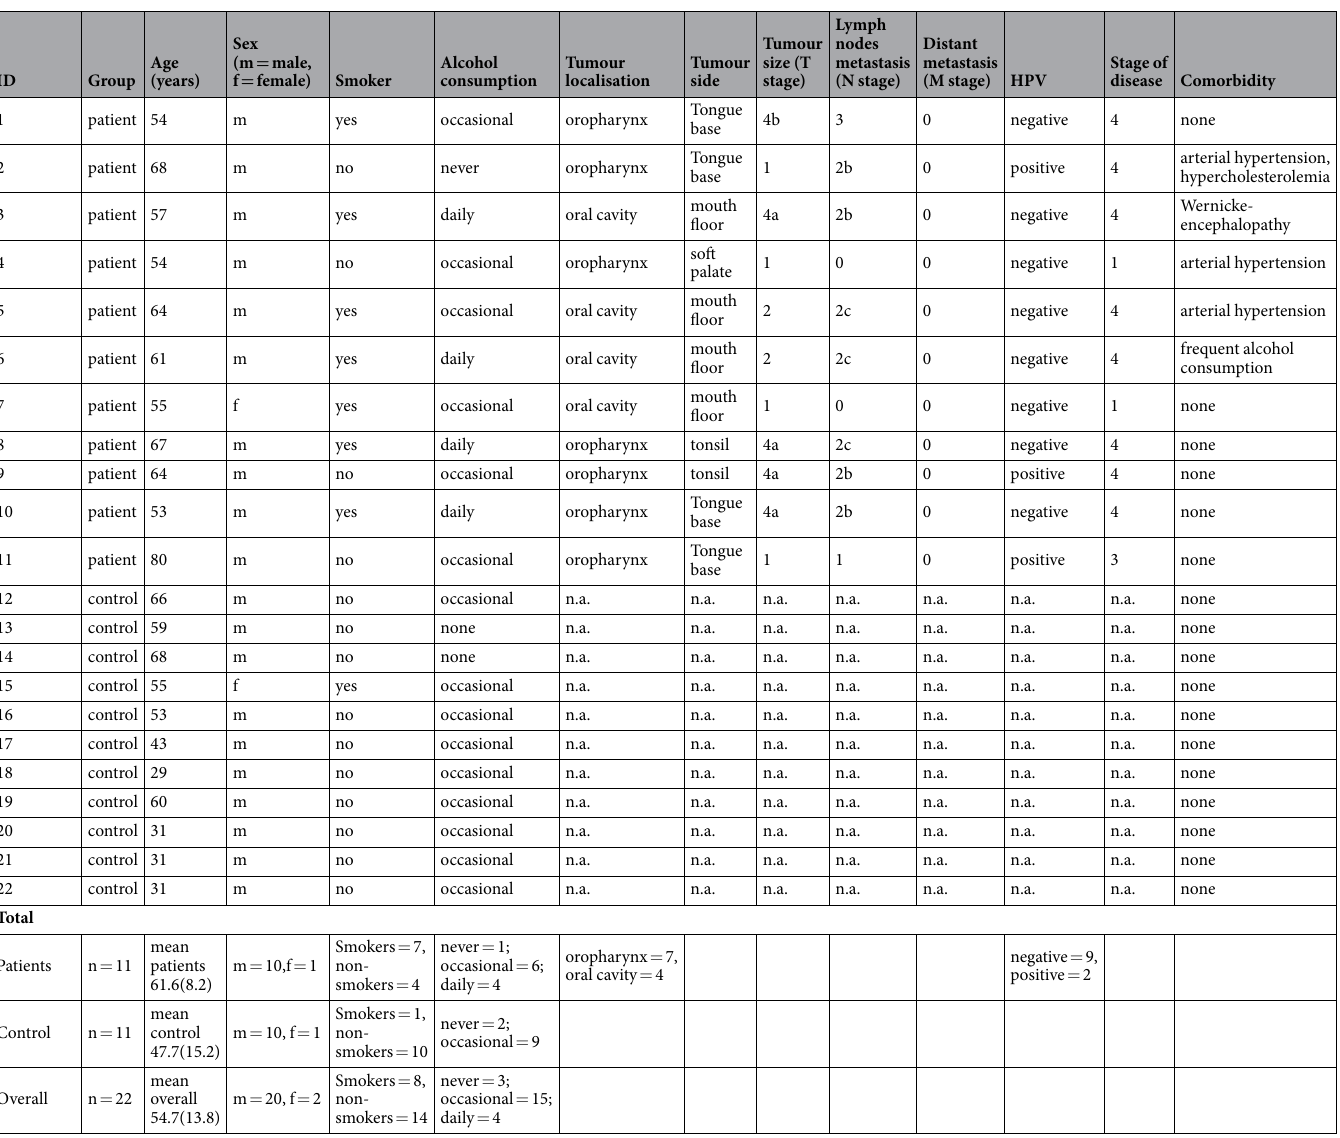
Table 1. Descriptive data of the study population. Information about tumour size, lymph node metastasis, distant metastasis and stage of diseases is provided according to TNM classification. Standard deviations are set in